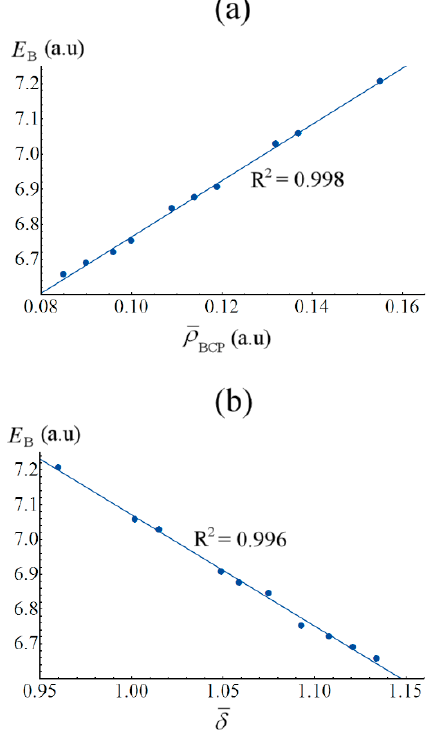
Figure 8. Correlation between the averaged QTAIM parameters of U–X, U–Y & U–Z bonds and the total binding energy in UX 2 Y 2 Z 2 complexes. ( a ) correlates (cid:1831) (cid:2886) and (cid:2025)̅ (cid:2886)(cid:2887)(cid:2900) , ( b ) correlates (cid:1831) (cid:2886) and (cid:2012)̅ ,